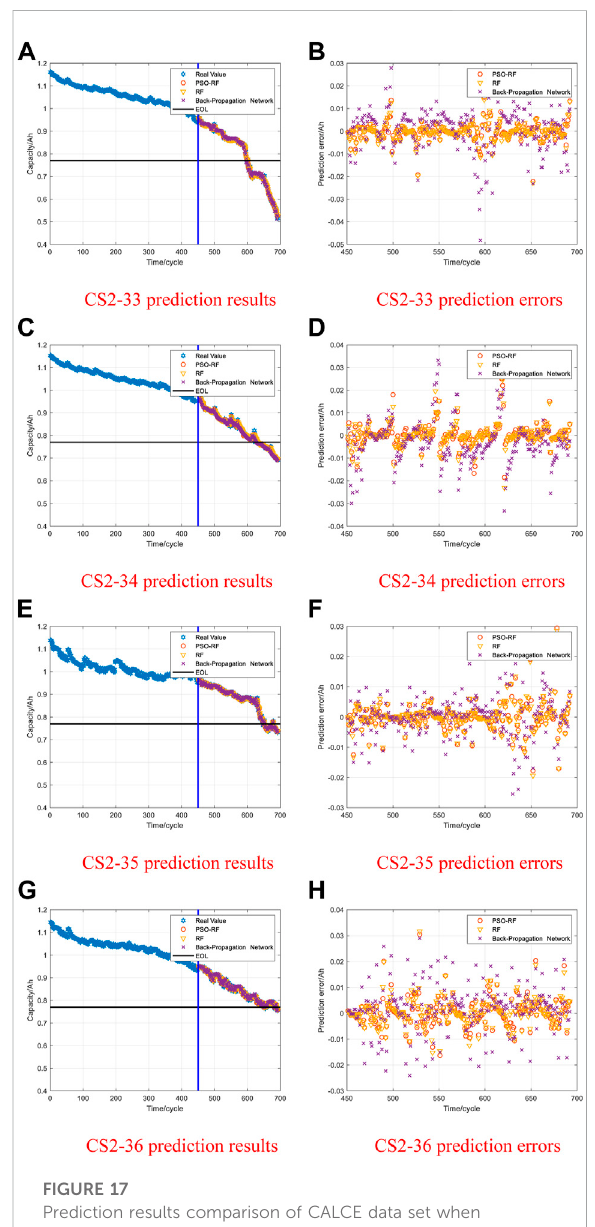
FIGURE 17 Prediction results comparison of CALCE data set when prediction starting point is